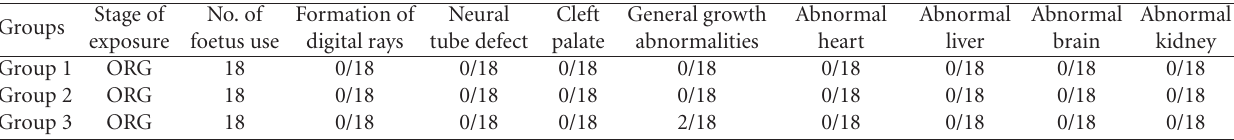
Table 3: Gross pathological (morphology) results of fetuses of treated animals.